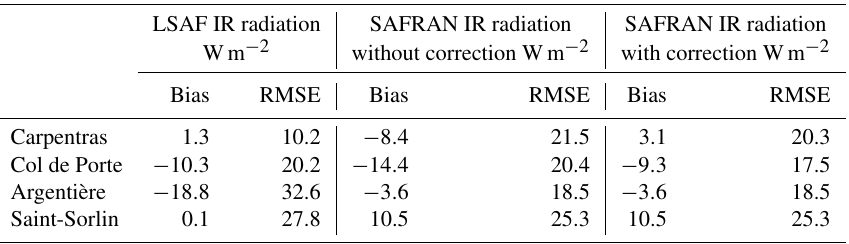
Table 2. Annual mean bias and RMSE of LSAF, SAFRAN, and corrected SAFRAN infrared radiations at Carpentras (95m), Col de Porte (1340m), Argentière (1900m), and Saint-Sorlin